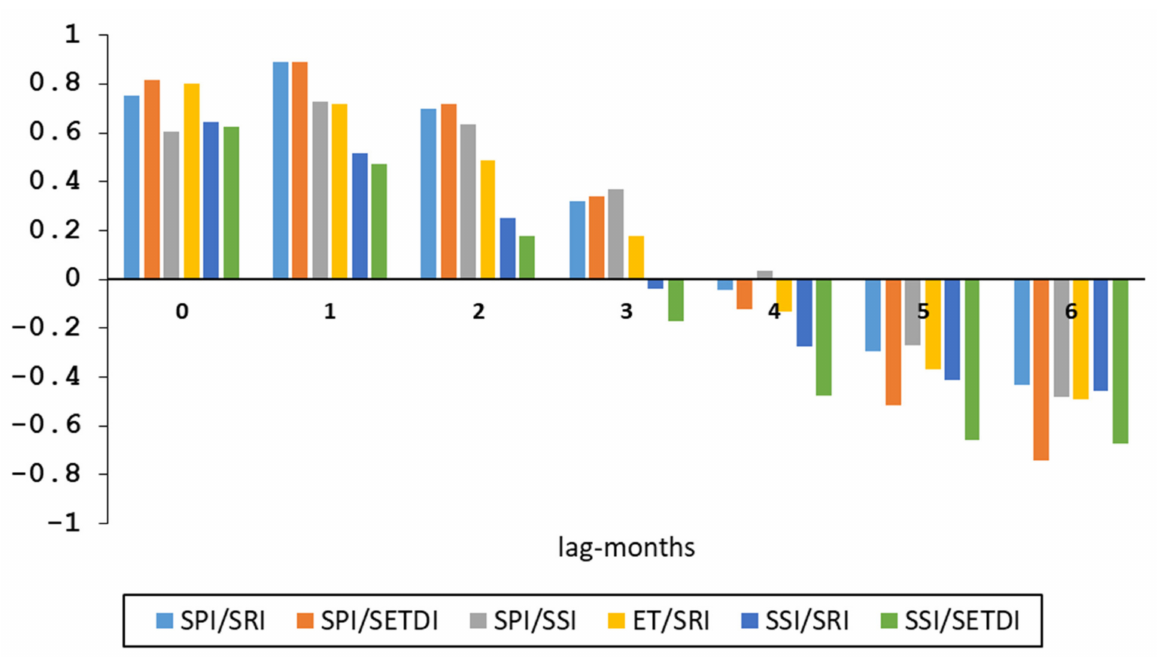
Figure 16. Correlation results among indices of 9-month accumulation period with a time lag up to 6 months.